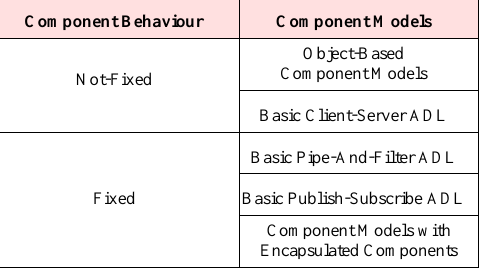
Figure 24. Behavior-based categories.